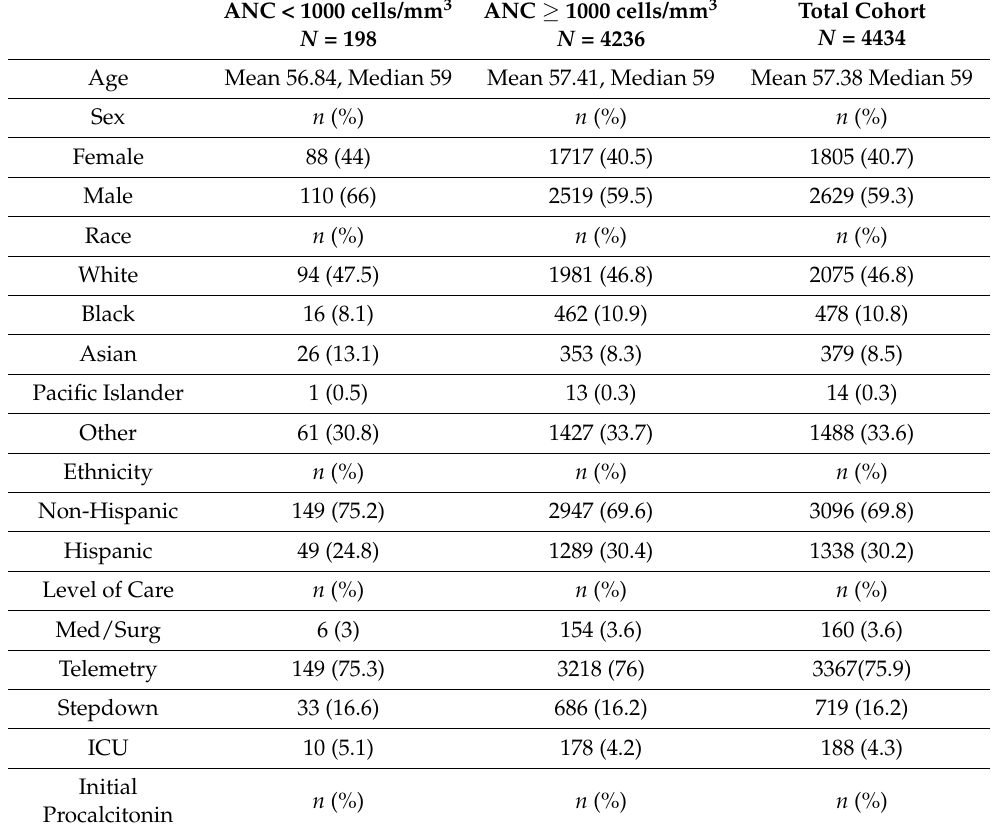
Table 1. Demographics and Outcome